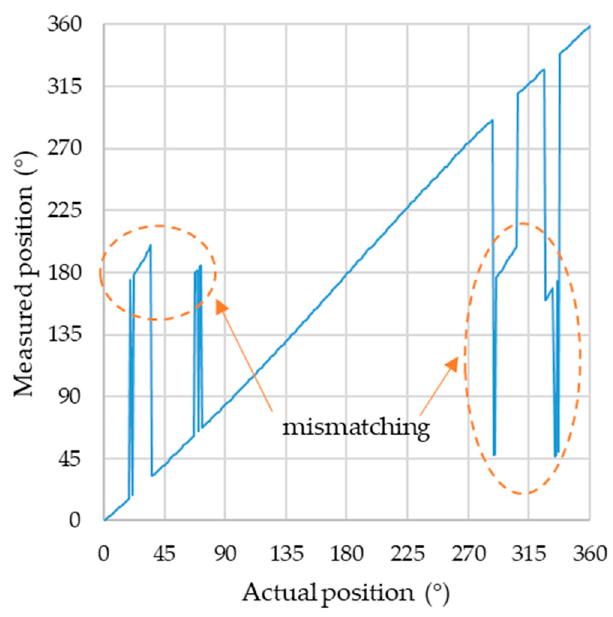
Figure 13. Measuring result for direct template matching.